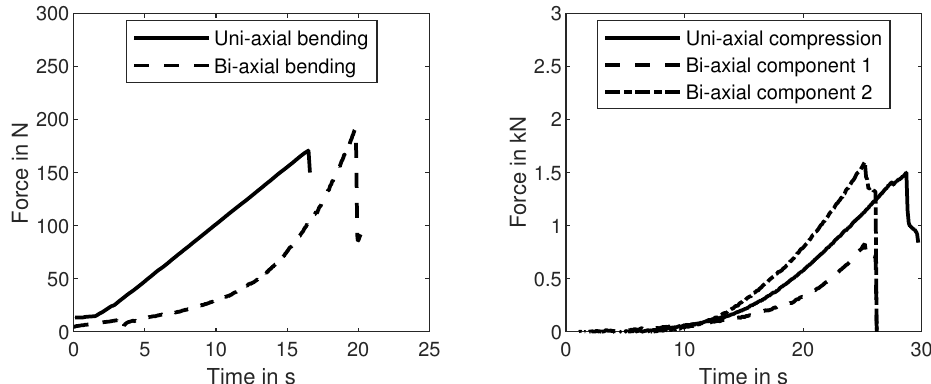
Figure 12. Typical examples of force signals of the performed experiments. On the left-hand side, one example for each of the bending experiments is depicted, while the two compression experiments are shown on the right. The bi-axial compression experiment has two independent force